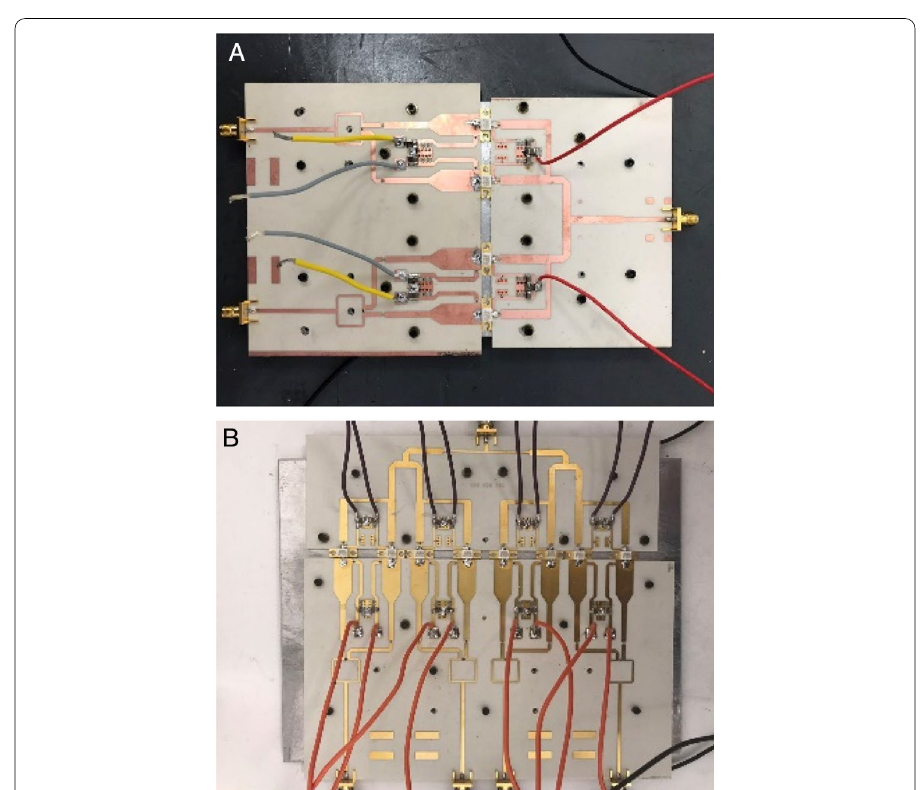
Fig. 12 Pictures of power combining modules for CANE. a Two-channel CANE. b Four-channel